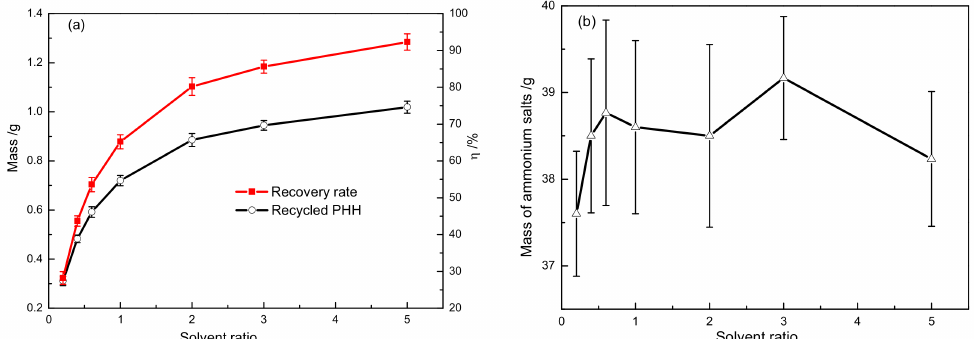
Figure 4. Effects of solvent ratio on the mass of recycled PHH and recovery rate η ( a ), as well as mass of recycled ammonium salts ( b ) at pH = 9.2 and 30 ◦